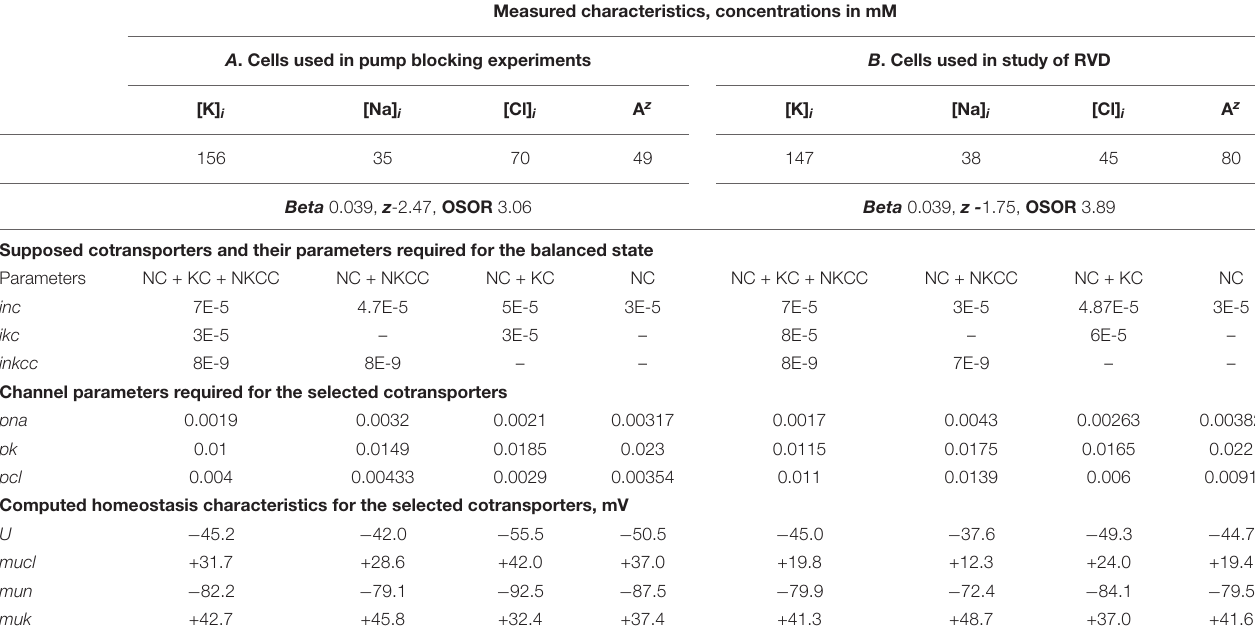
TABLE 2 | Basic characteristics of ion distribution measured for two examples of normal resting U937 cells ( A and B ), equilibrated with standard RPMI medium, and calculated for cells with different set of